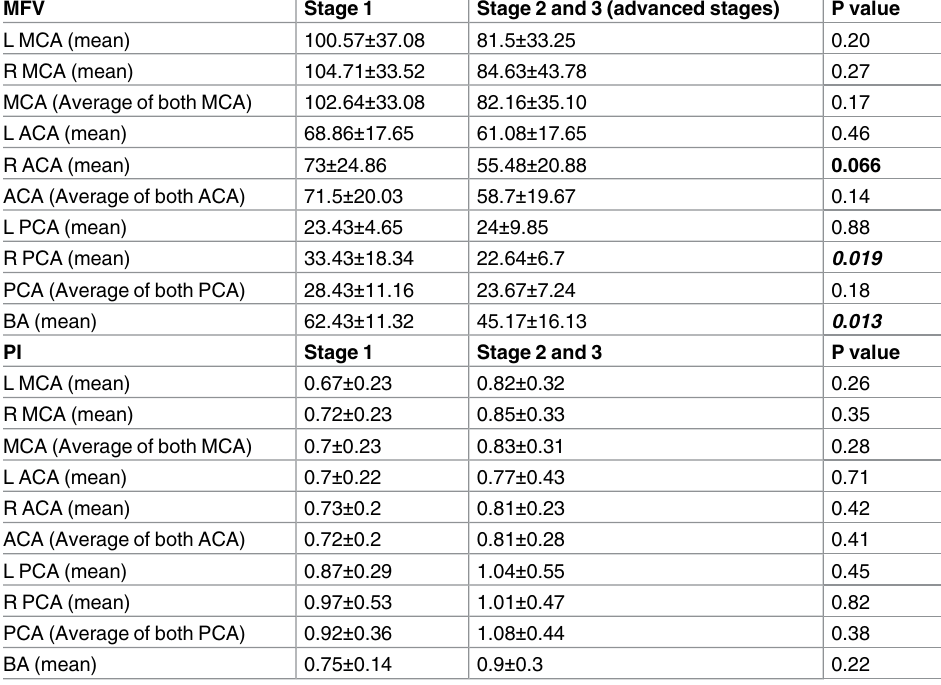
Table 2. Mean flow velocities and pulsatility index in the patients with various stages of admission. ACA-anterior cerebral artery; BA- basilar artery; MCA-middle cerebralartery; PCA- posterior cerebralartery. MFV Stage